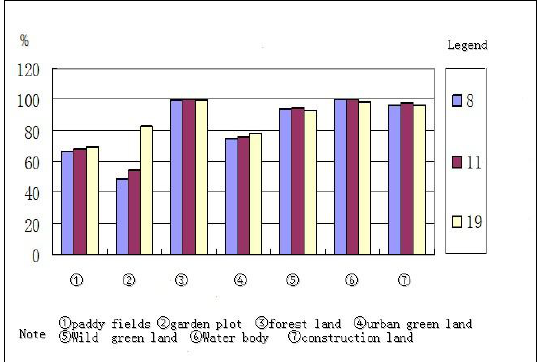
Figure4. Comparison of producer's accuracy based different factor